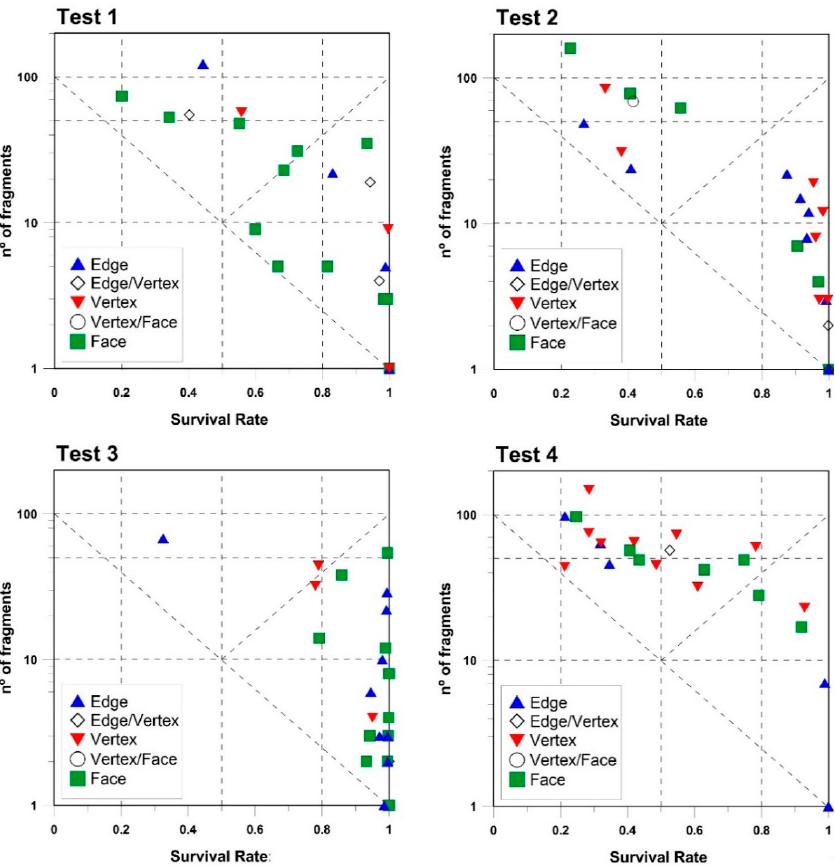
Figure 20. Survival rate versus number of fragments produced for each tested block combined with the impact geometry, for each test